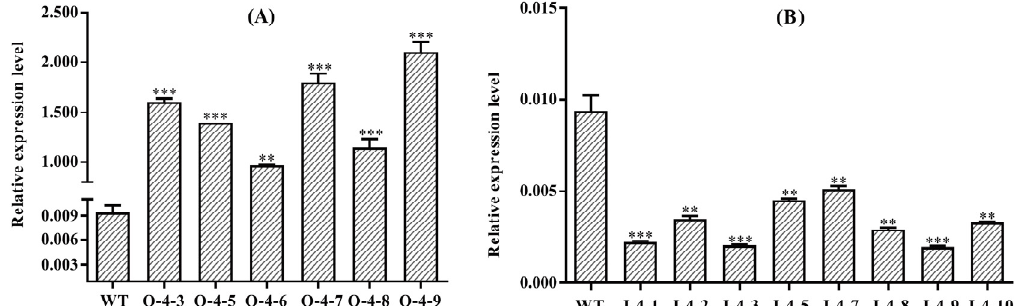
Figure 3. Expression of SmMYB4 in the transgenic lines. ( A ,B) indicates the expression level of SmMYB4 in the overexpressing lines and RNAi lines, respectively (** p < 0.01, *** p < 0.001).